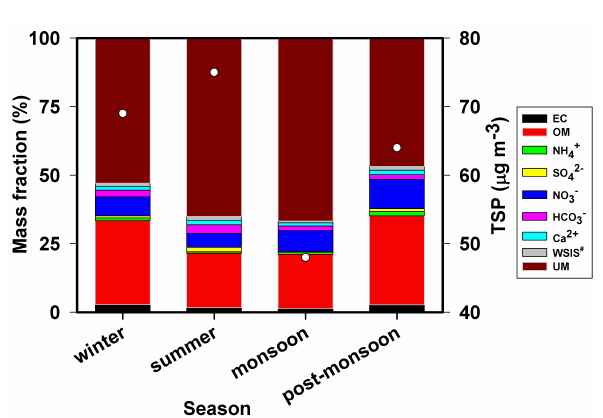
Fig. 4. Chemical composition of aerosols collected at Manora Peak for the four seasons. OM refers to the organic matter (=1.8 × OC), WSIS # (sum of Cl − , K + , Mg 2 + and Na + ) and unaccounted mass (UM) is defined as TSP – OM – EC – WSIS # . The open circles represent the TSP mass